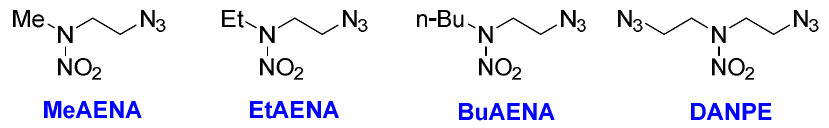
Figure 1. Common azidoalkyl nitramine plasticizers.